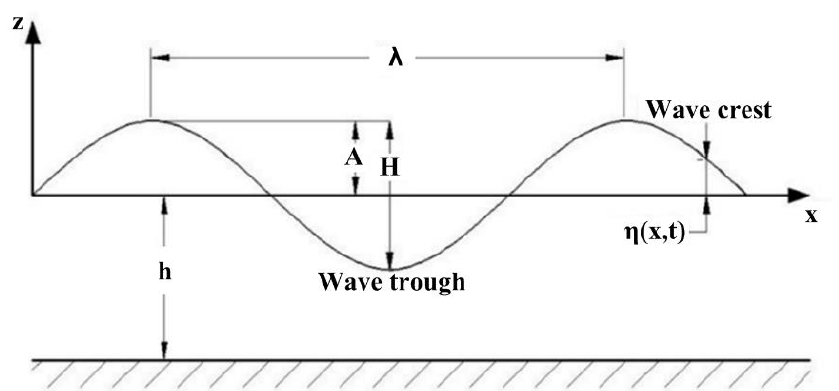
Figure 2. Wave characterization (adapted from Dean and Darlymple [31]).